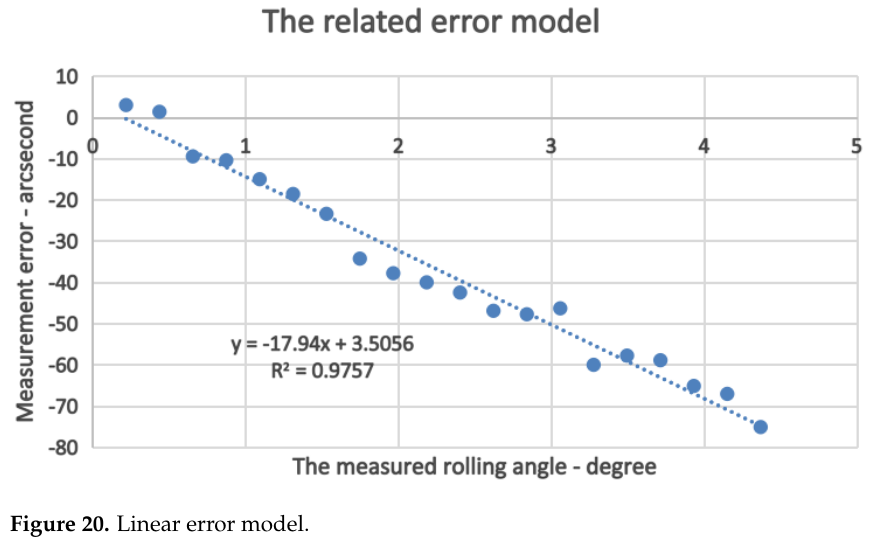
Figure 19. Repetitive error curves.